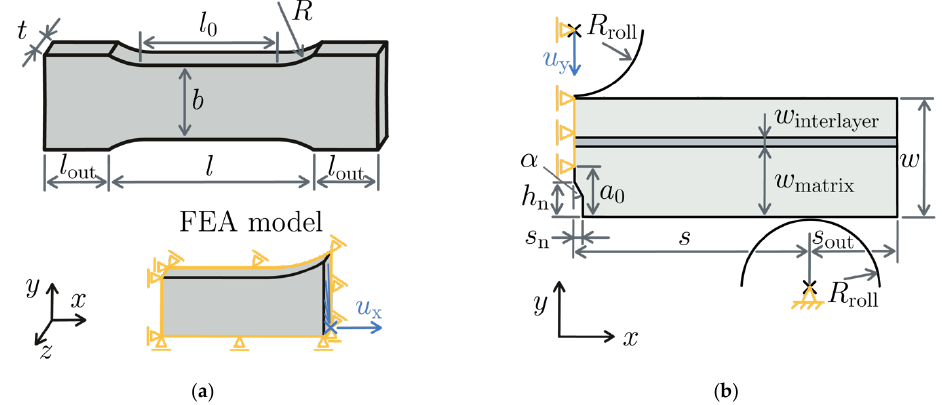
Figure 3. Model setup of ( a ) tensile model and ( b ) three-point bending model. Table 1. Geometry, loading, and material parameters of the FEA models. Tensile Test